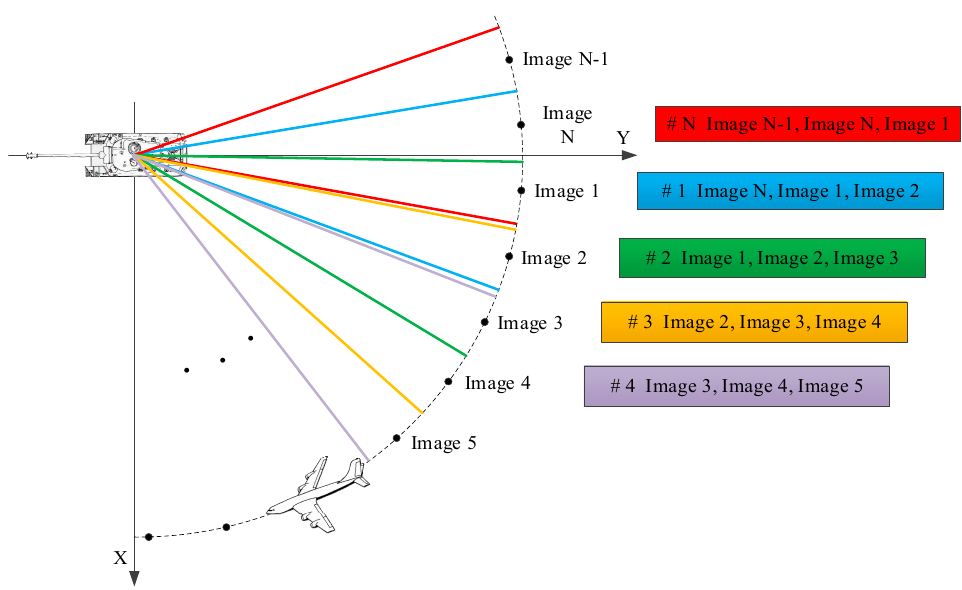
Figure 4. Example of three-view SAR image combinations.